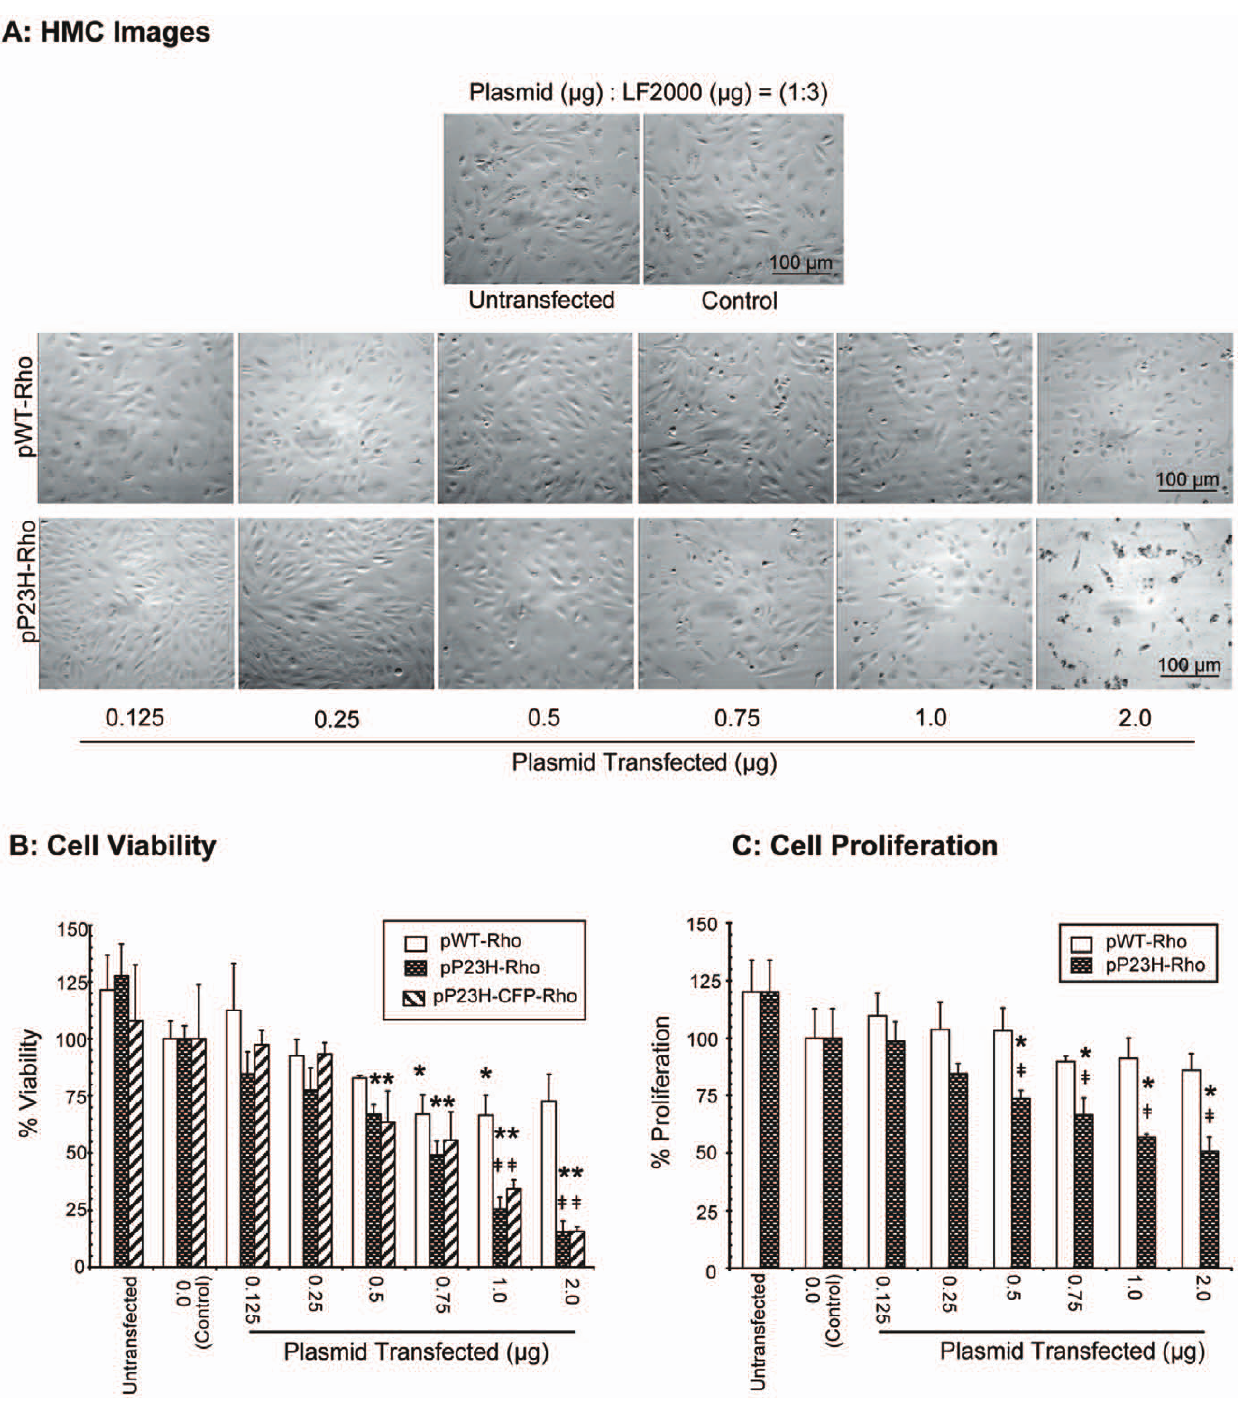
Figure 2. P23H rhodopsin is toxic to RPE cells. A ) For HMC images, cells were visualized using Nikon inverted light microscope at 10x magnification. Representative images from one of the three independent studies have been shown. B ) For cell viability, the cells were trypsinized, collected and resuspended in PBS. Total number of viable cells was determined in each group using trypan blue dye and percent viability was calculated with respect to the group transfected with LF2000 (Lipofectamine H 2000) alone. C ) For cell proliferation cells were treated with BrDU for 24 h and then detected using anti-BrDU antibody. The percentage proliferation was calculated with respect to LF2000 transfected group. Data is expressed as mean 6 S.D. for N=3. *, p , 0.01 compared with corresponding pWT-Rho transfected group. *, p , 0.05 compared to LF2000 group. doi:10.1371/journal.pone.0024616.g002 pP23H-Rho transfected groups. While there was no significant Rho/pP23H-CFP-Rho groups at 1 and 2 m g doses. At the 2 m g difference at 0.25, 0.5, and 0.75 m g doses, there was a significant dose for instance, the viability with pWT-Rho was 72 6 11% as opposed to 15 6 1% with pP23H-CFP. difference between the cell viability of pWT-Rho and pP23H-